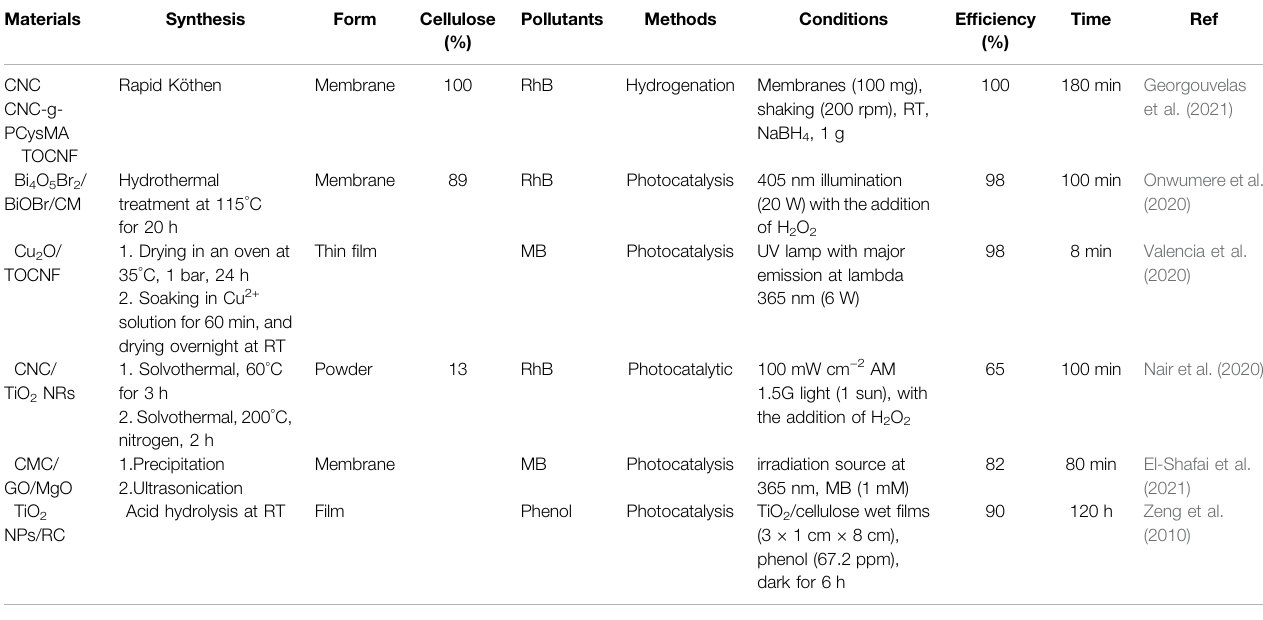
TABLE 5 | Cellulose-based materials for water treatment via catalysis.